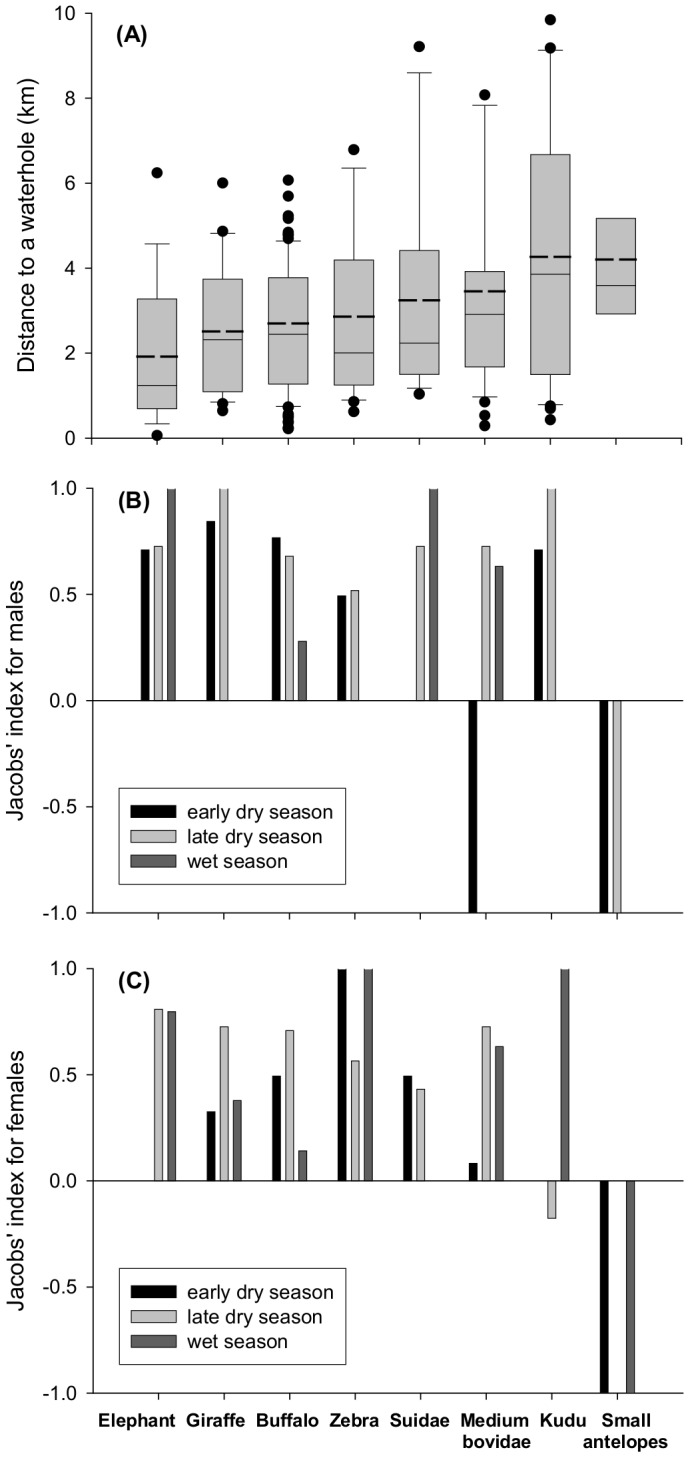
(A) Mean distance to a waterhole for kills for the different prey species. Boxes show medians, 25% and 75% quartiles.Bold dashed lines indicate means. Whiskers indicate the range between 10% and 90% percentiles. Dots represent data outside this range. (B) and (C) Jacobs’ index of seasonal preference to kill within 2 km of a waterhole for the different prey species for male and female lions respectively. Values >0 indicate preference, values <0 suggest use but avoidance.